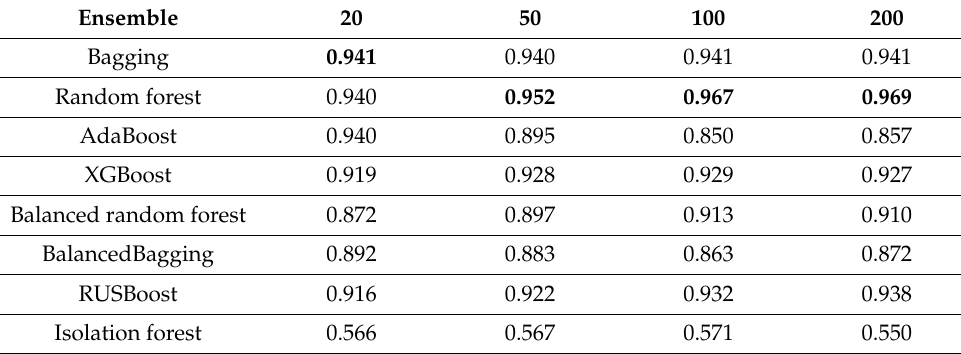
Table 8. The AUROC performance metric of different ensembles of classifiers (decision trees) with various sizes of ensembles (Bold numbers show the best